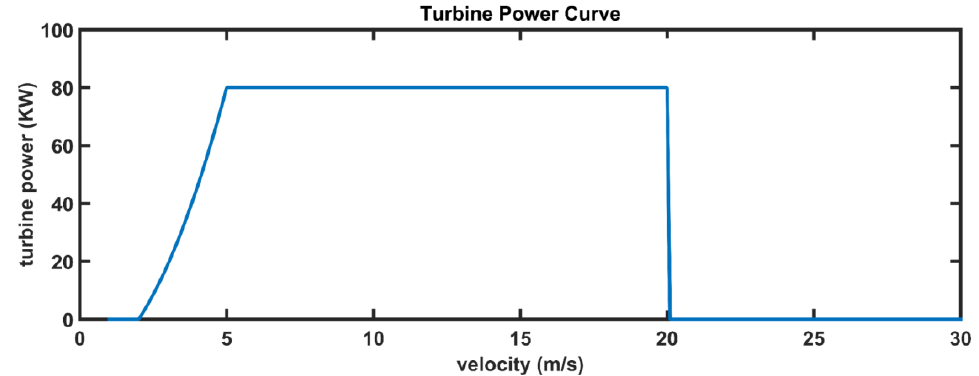
Figure 2. Power curve for 80 MW wind farm.